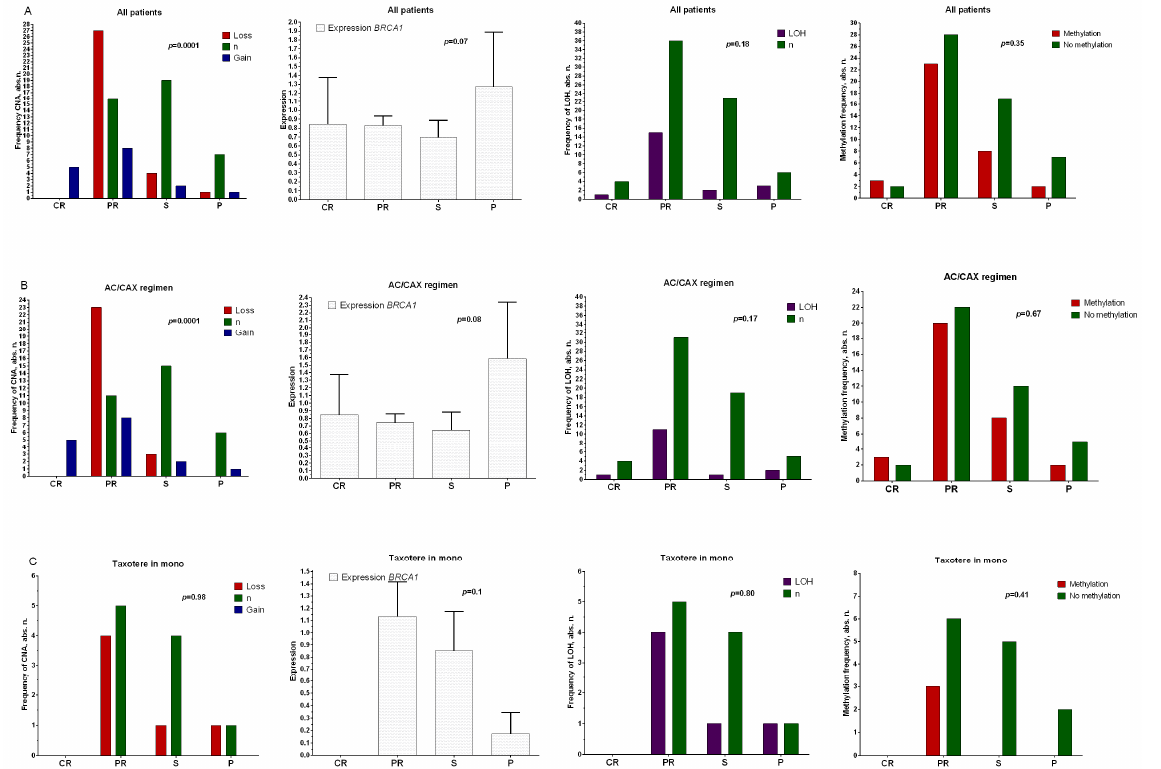
Figure 1. Relationships between CNA, gene expression, sites of loss of heterozygosity, and methylation of the promoter region of the BRCA1 gene with the effectiveness of NAC in a general group of patients ( A ), those treated with anthracycline-containing regimen (AC/CAX) ( B ), and those treated with taxotere monotherapy ( C ). Note: abscissas show the effect of neoadjuvant chemotherapy. CR: complete regression; PR: partial regression; ST: stabilization; P: progression. A nonparametric Kruskal– Wallis test was used to assess the differences among independent samples in terms of expression level. Frequency comparisons are based on two-tailed Fisher’s test or chi-squared